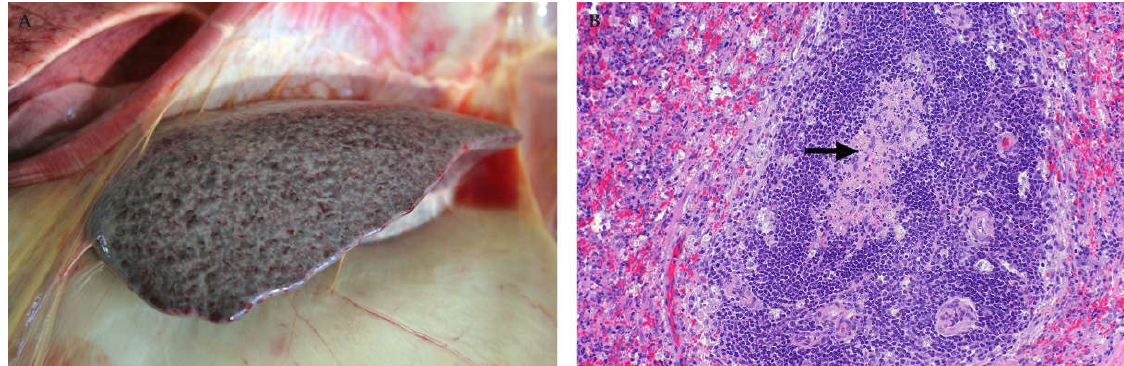
Figure 8. Spleen of an RVFV-infected adult sheep. ( A ) Scattered sub-capsular petechiae are present. ( B ) Lymphocytolysis is most apparent in the germinal centre (arrow) (H&E stain), mag 200×.